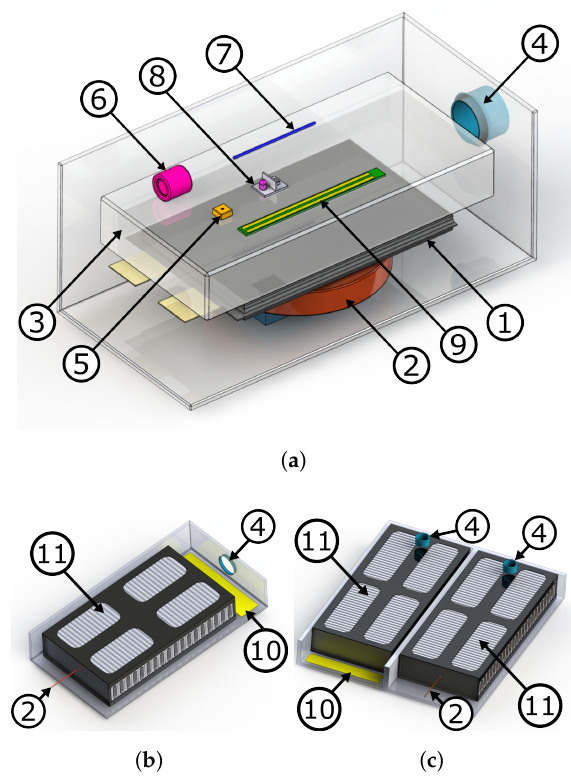
Figure 1. Drawings of the three different test setups. ( a ) Setup V1, ( b ) setup V2 and ( c ) setup V3. The housings are only partially shown for better visibility of the cells (1) and cell modules (11).